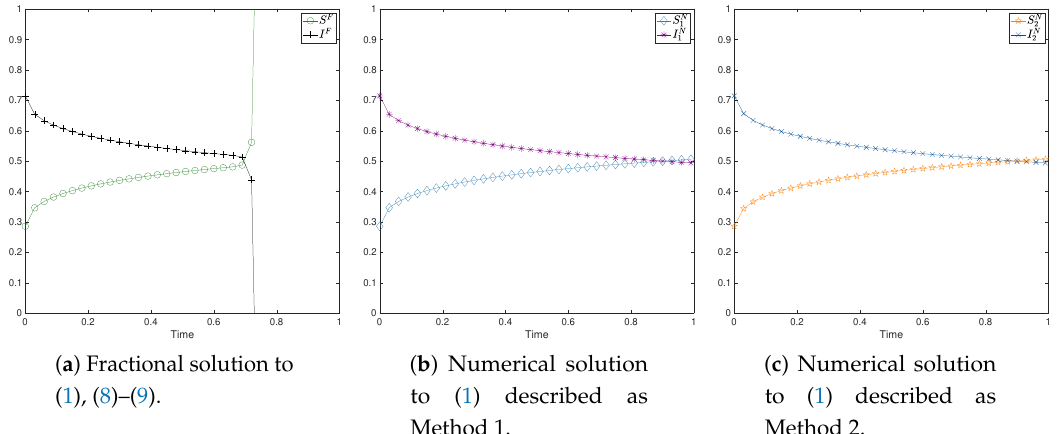
Figure 6. Comparison between the fractional solutions to (1) with α =